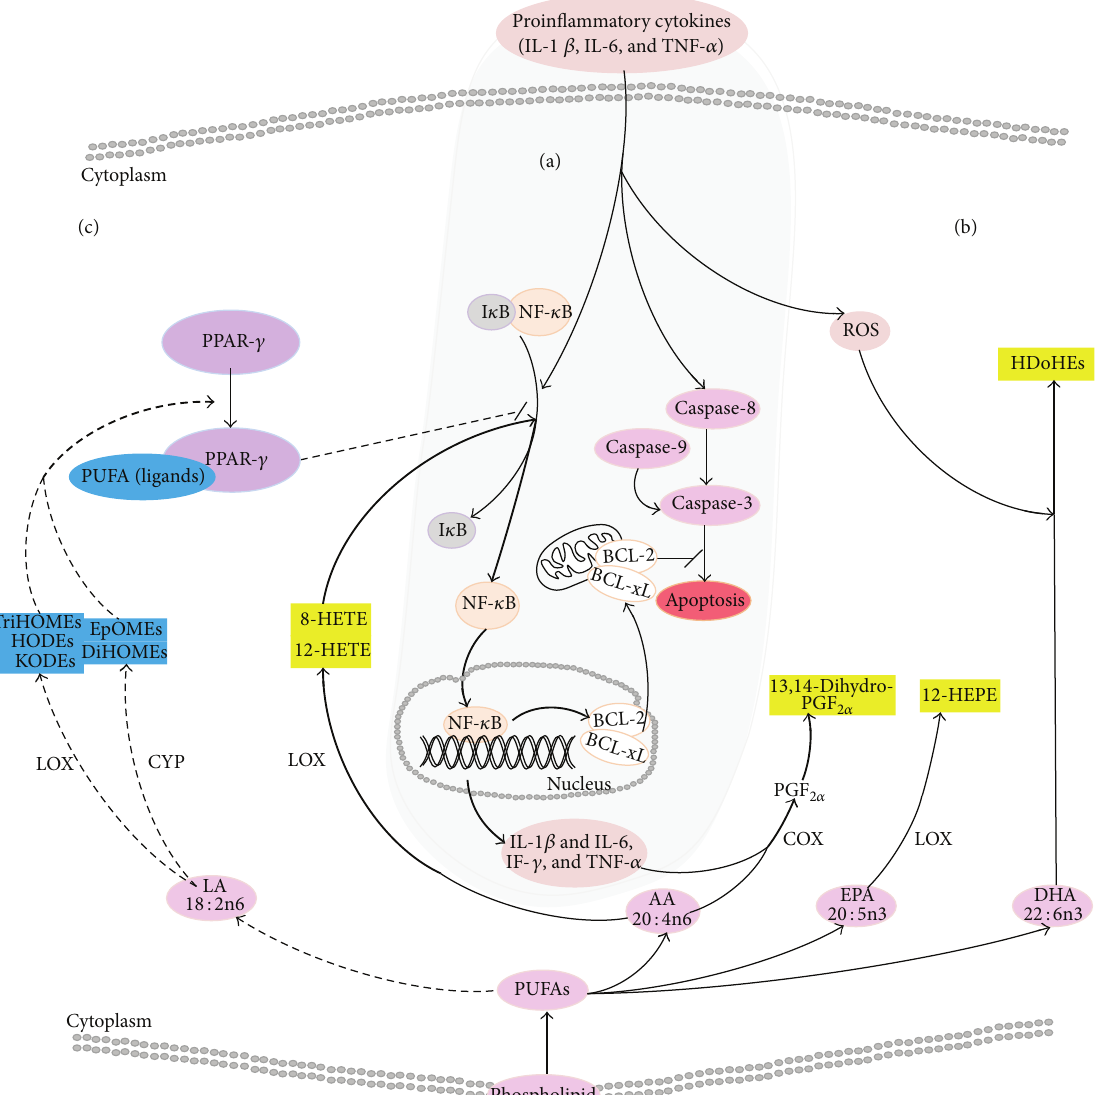
Figure 4: A systematic autoimmune activation in RA. Appearance of proinflammatory cytokines (IL-1 𝛽 and IL-6, TNF 𝛼 ) as well as the appearanceofROSinRA.Thecytokinesnormallyinducetheapoptosisviathecaspasepathwaybutalsoinhibitapoptosisthroughdegradation I 𝜅 B activating nuclear factor- 𝜅 B (NF- 𝜅 B), which consequently translocate to the nucleus upregulating the antiapoptotic genes (BcL2 and BcL-xL). The activated NF- 𝜅 B then can also further enhance the production of proinflammatory cytokines and chemokines as well as COX- II enzyme. (b) Upregulated oxylipin response. During RA increased levels of AA derived prostaglandins and HETEs are detected. 8- and 12-HETE are able to activate NF- 𝜅 B exasperating RA. Due to increased levels of ROS, DHA derived peroxidation products are also found. (c) Dysregulated anti-inflammatory response. LA derived oxylipins including HODEs, KODEs, TriHOMEs, DiHOMEs, and EpOMEs are ligands of peroxisome proliferator-activated receptor- (PPAR-) 𝛾 . Due to decreased levels of these anti-inflammatory oxylipins, the ability of PPAR- 𝛾 to inhibit the activation of NF- 𝜅 B and indirectly affect apoptosis is